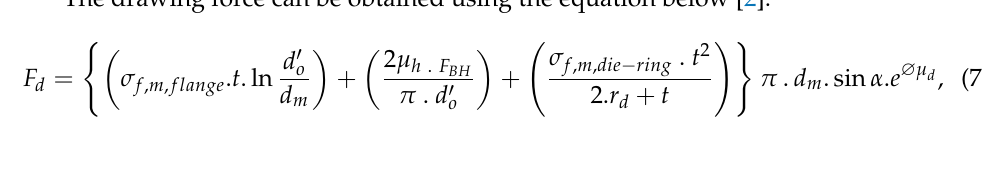
Figure 5. Deep drawing configurations: ( a ) before the process; ( b ) during the process. The drawing force can be obtained using the equation below [2].